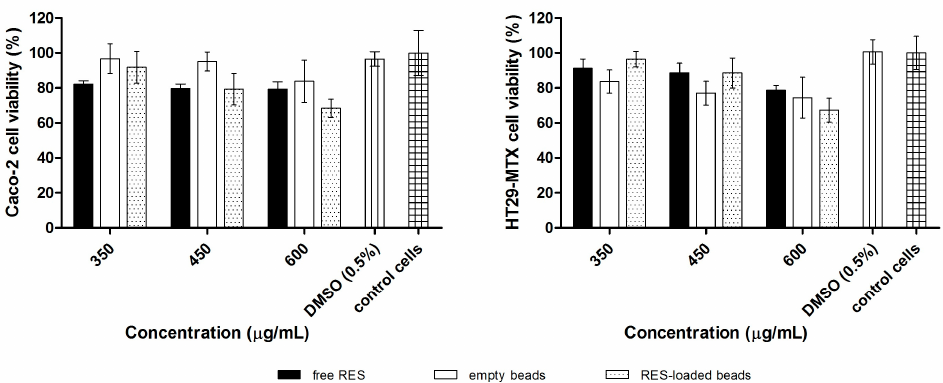
Figure 4. Cell viability (%) of Caco-2 and HT29-MTX cell lines after 4 h of incubation with increasing concentrations of free RES, and empty and RES-loaded beads (mean ± SD).